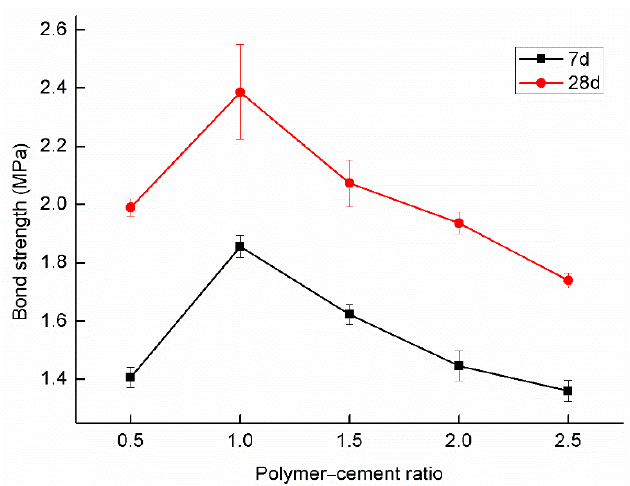
Figure 8. Test results of bonding strength of different polymer–cement ratios.